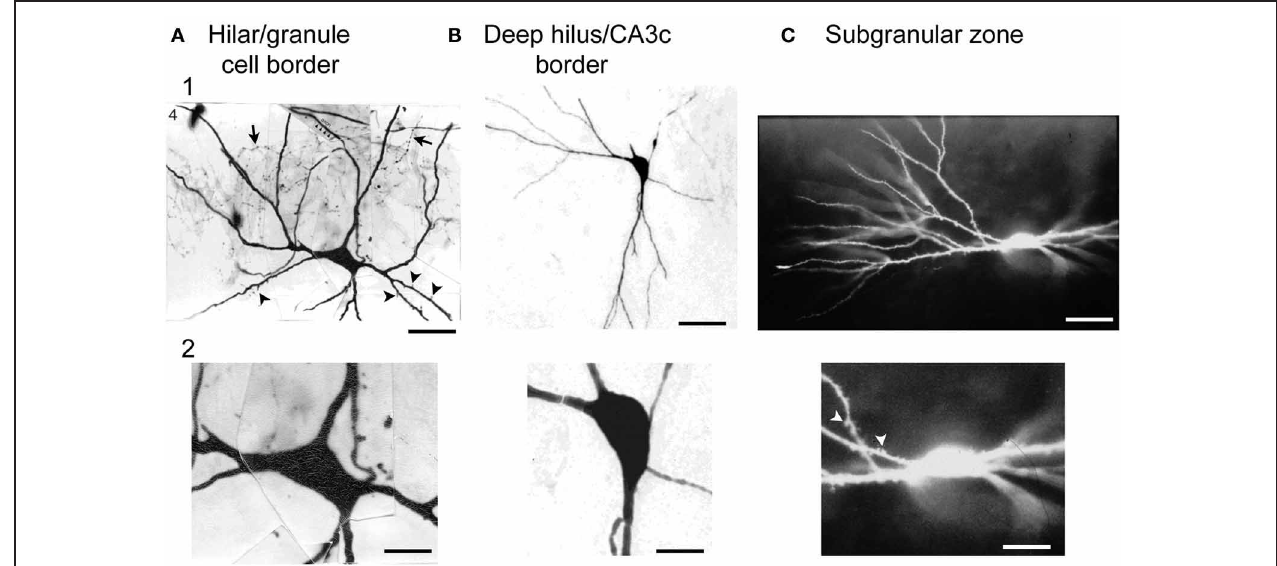
area CA3c with a large cell body. Same calibration as (A) . (C) A neuron with dense spines all over its dendrites, with physiological characteristics that were not possible to discriminate from mossy cells with large thorny excrescences. This neuron was filled with Lucifer yellow and located on the border of the subgranular zone and the deep hilus. Same calibration as (A) . From Scharfman